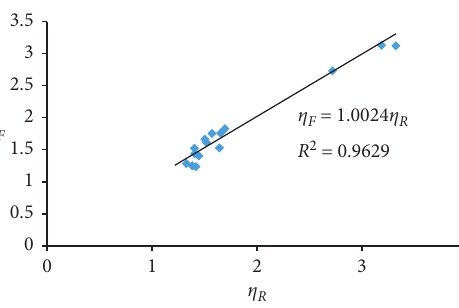
Figure 4: The correlation diagram of η